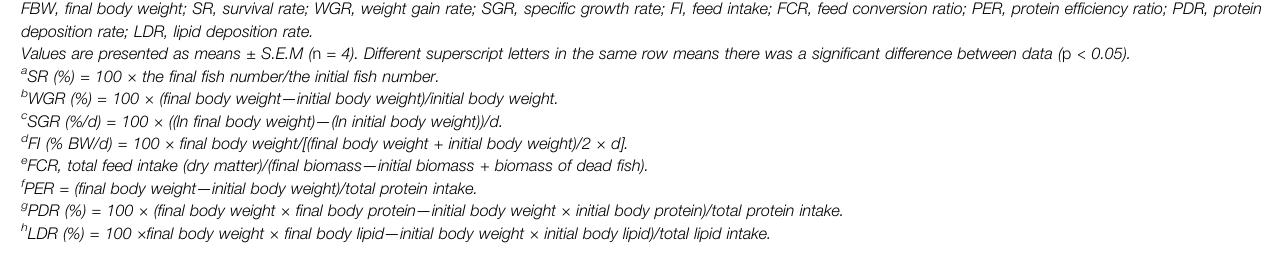
TABLE 4 | Effects of different viscous guar gum on morphological parameters of juvenile largemouth bass. Group Hvs-GG Morphological parameters CF a (g/cm 3